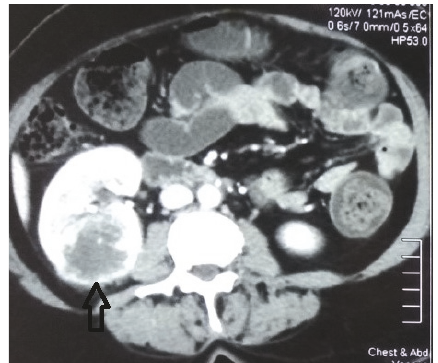
Figure 2: Renal cell carcinoma of the right